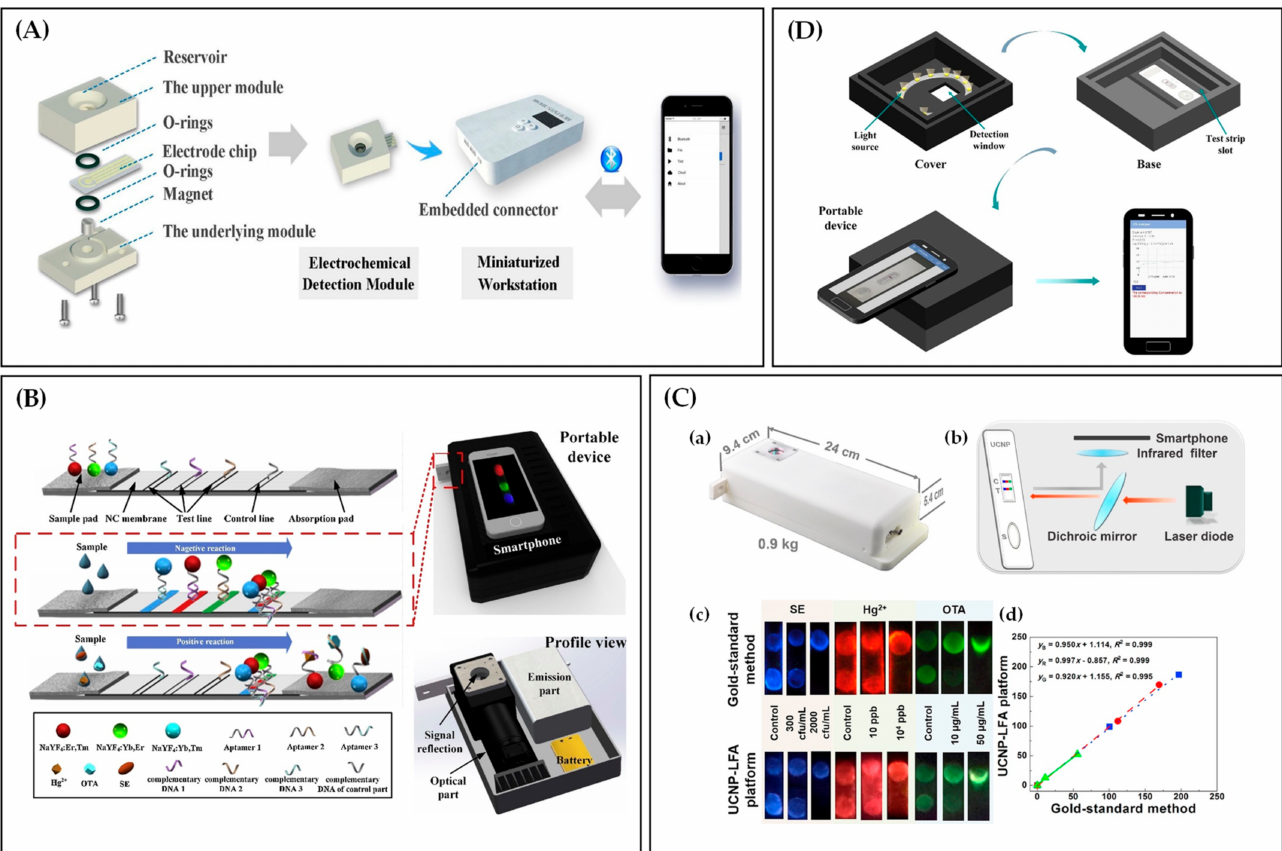
Figure 6. ( A ) Schematic of the electrochemical sensing unit. Reprinted with permission from Ref. [105], copyright 2020, Elsevier. ( B ) Schematic of lateral flow aptamer assay for simultaneous three kinds of targets detection. Reprinted with permission from Ref. [108], copyright 2018, Elsevier. ( C ) Photograph ( a ) and schematic ( b ) of UCNP-LFA reader. ( c , d ) Detection results of SE, Hg 2+ , and OTA using the UCNP-LFA platform and the gold-standard method. Reprinted with permission from Ref. [112], copyright 2019, Elsevier. ( D ) Detection result readout process based on a smartphone-based portable gadget and custom-designed app. Reprinted with permission from Ref. [114], copyright 2021,